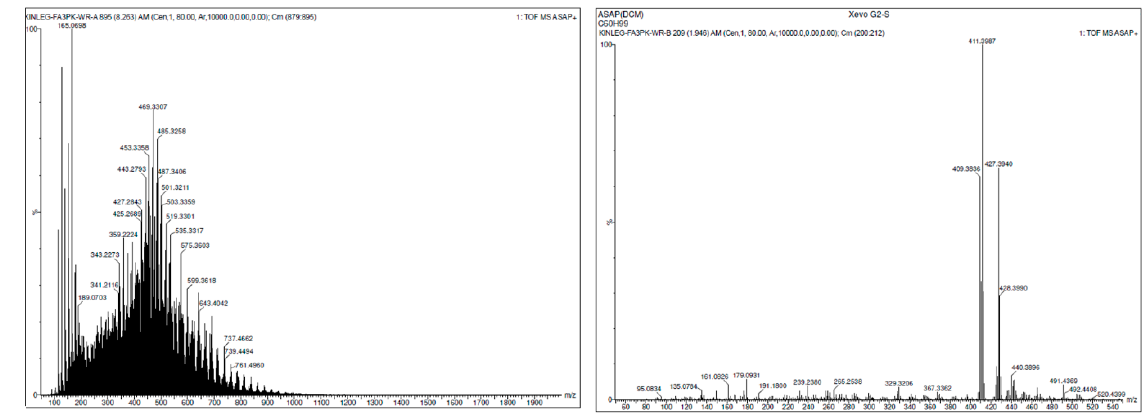
Figure 3. ( Left ) ASAP TOF Mass Spectrometry analysis of a mixture of unsaturated hydrocarbons with a wide range of molecular masses observed from m/z 150 to at least m/z 1000 according to the National MS centre, EPSRC, Swansea ( Right ) ASAP TOF Mass Spectrometry analysis of non-irradiated squalene.